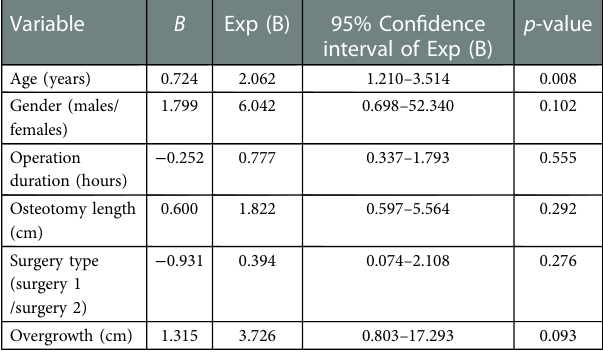
Surgery 1: Salter pelvic osteotomy combined with femoral shortening osteotomy. Surgery 2: Pemberton osteotomy of pelvis combined with femoral shortening osteotomy. DDH, developmental dysplasia of the hip; LLD, limb length